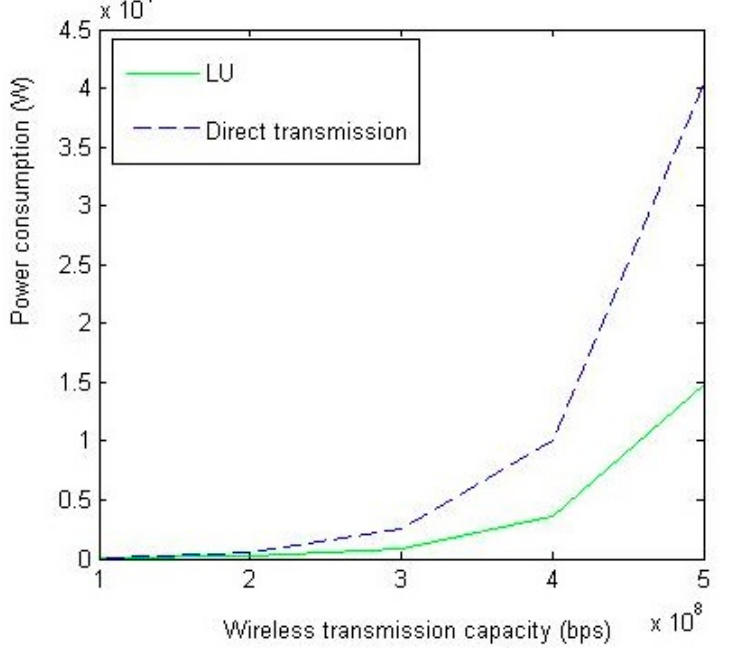
Figure 4. The impact of C on system power consumption (the total power consumed in system under different configurations of wireless transmission capacity (bps)).